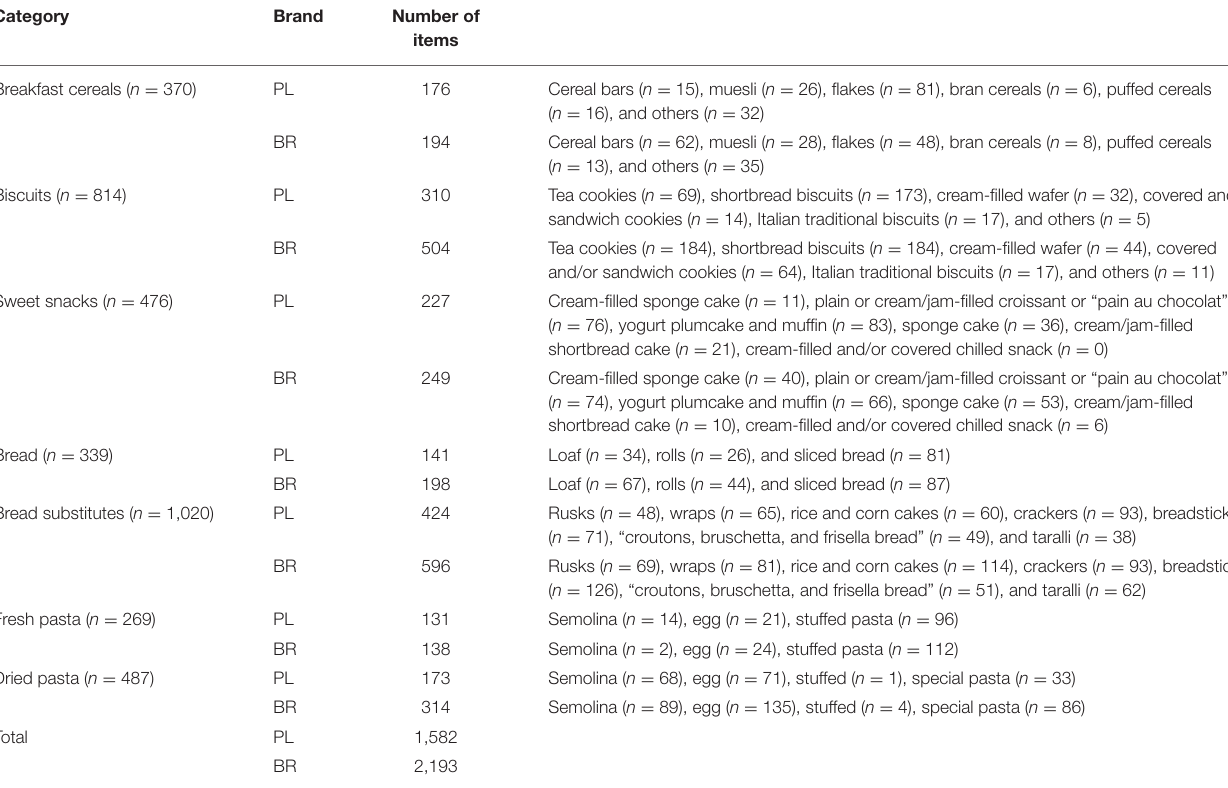
TABLE 1 | Number and types of private-label (PL) and branded (BR)